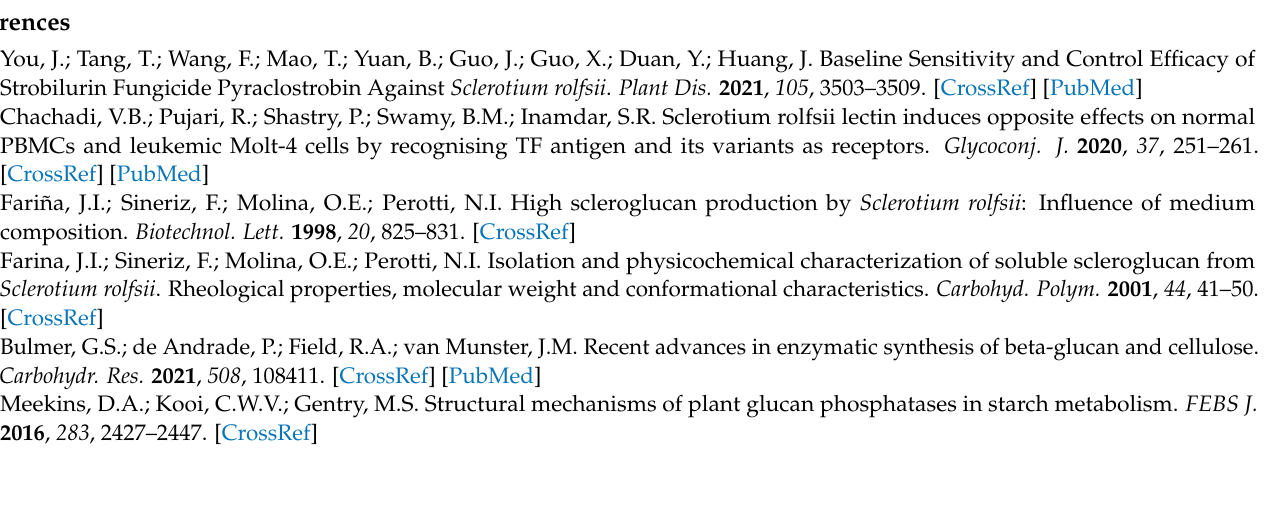
by DEGs and DEMs, Table S3: Transcriptomics expression analysis, Table S4: Metabolomics expression